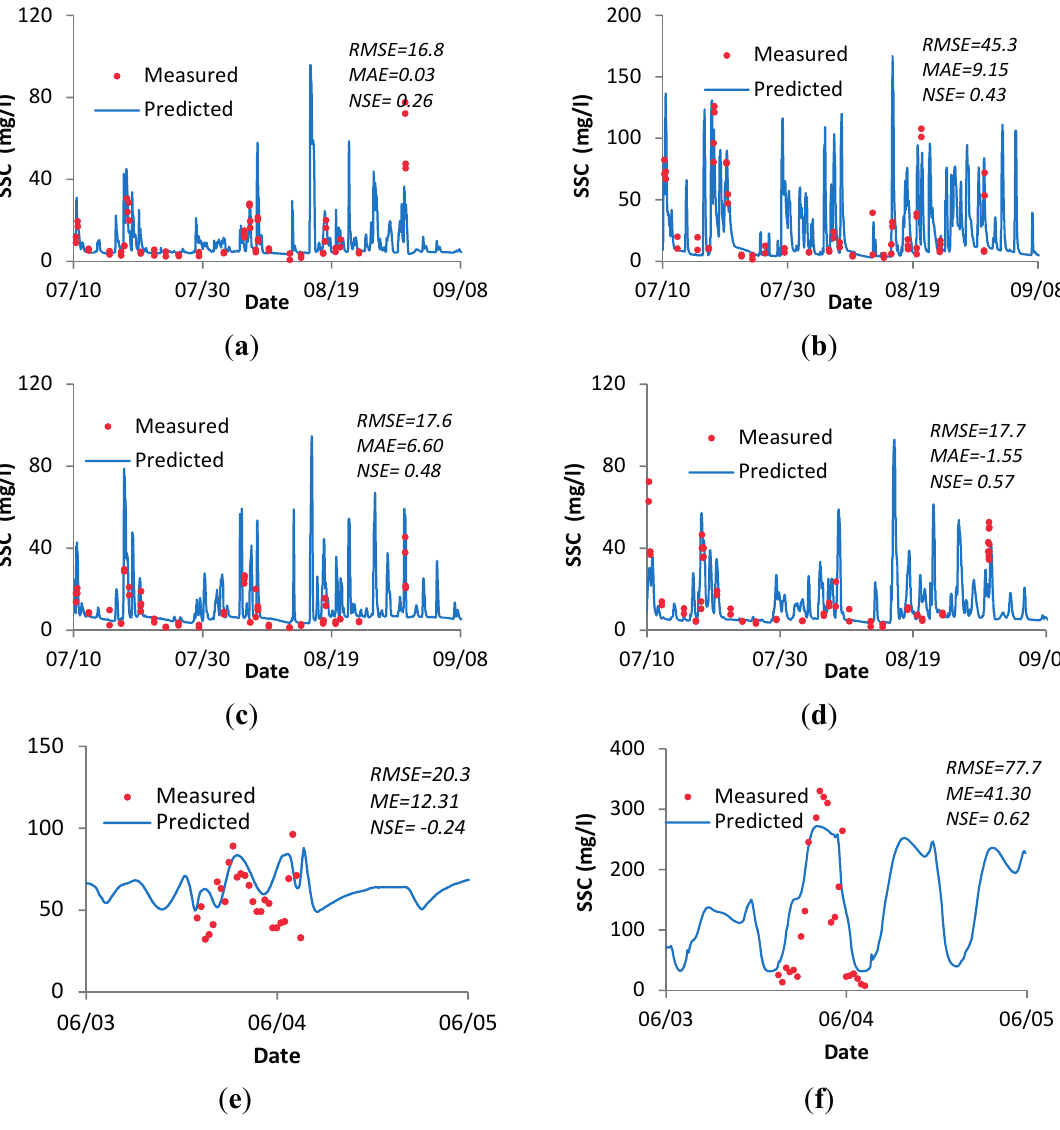
Figure 3. Suspended sediment concentrations (SSCs) verification at 4 monitoring sites along the river Ribble in 2012 and 2 riverine and coastal sites in 1999 (see Figure 1 for locations) at sites: ( a ) Site 710305 (see Figure 1); ( b ) Site 713122; ( c ) Site 711610; ( d ) Site 713019; ( e ) Site Bullnose; ( f ) Site